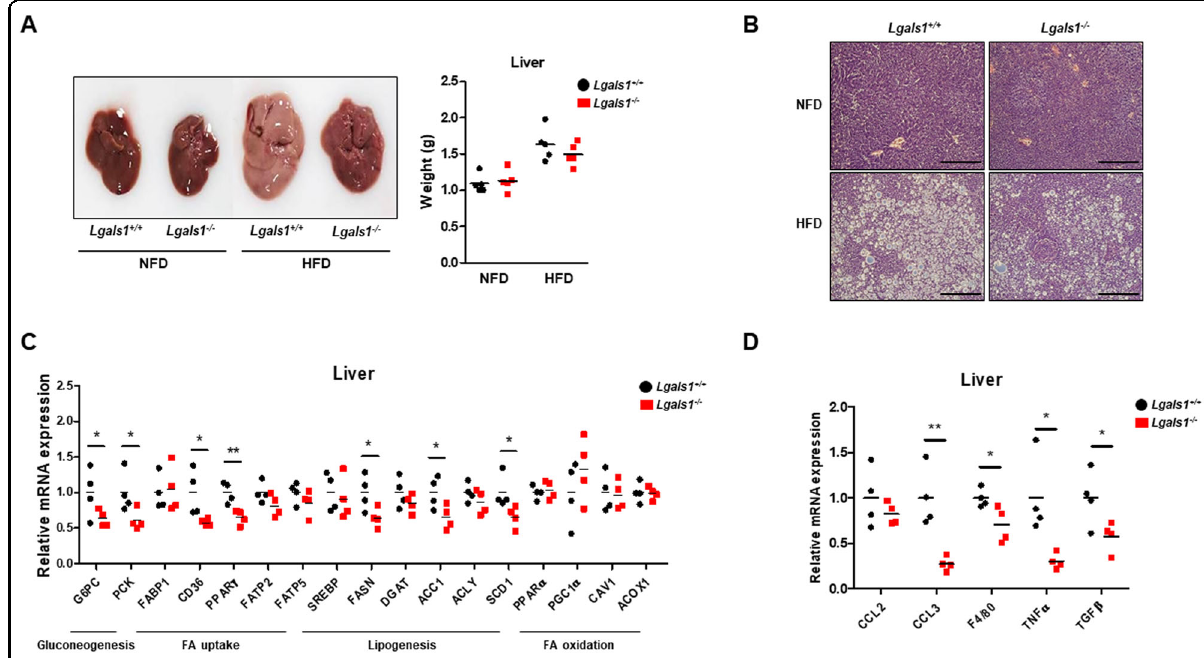
Fig. 6 Lgals1 − / − mice showed the amelioration of fatty liver phenotype. Both Lgals1 + / + and Lgals1 − / − mice were fed a NFD or a HFD for 10 weeks ( n = 5 per group). a Liver sizes and weights from Lgals1 + / + and Lgals1 − / − mice fed a NFD or a HFD were analyzed and presented as a picture and a graph. b Slide sections of liver from Lgals1 + / + and Lgals1 − / − mice fed a NFD or a HFD were prepared and stained with H&E. Bars indicated 100 μ m. c The expression of genes involved in gluconeogenesis, such as G6PC and PCK, in fatty acid uptake, such as FABP1, CD36, PPAR γ , FATP2 and FATP5, in lipogenesis, such as SREBP, FASN, DGAT, ACC1 ACLY and SCD1, and in fatty acid oxidation, such as PPAR α PGC1 α , CAV1 and ACOX1 in livers from Lgals1 + / + and Lgals1 − / − mice fed a HFD was analyzed by quantitative RT-PCR. d The expression of genes, included F4/80, CCL2, CCL3, TNF α and TGF β in livers from Lgals1 + / + and Lgals1 − / − mice fed a HFD was analyzed by quantitative RT-PCR. Data are presented as the mean ± SEM * p < 0.05 and ** p < 0.01 for the Lgals1 + / + mice vs. the Lgals1 − / −